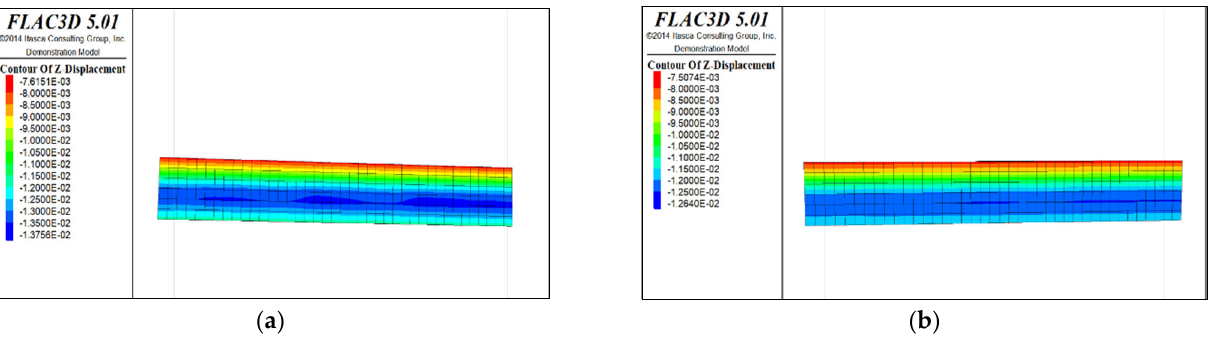
Figure 5. Z-direction displacement cloud pictures (plan views) of the roof protection layer after the completion of extraction and backfilling under Schemes D and F. ( a ) Scheme D. ( b ) Scheme F.